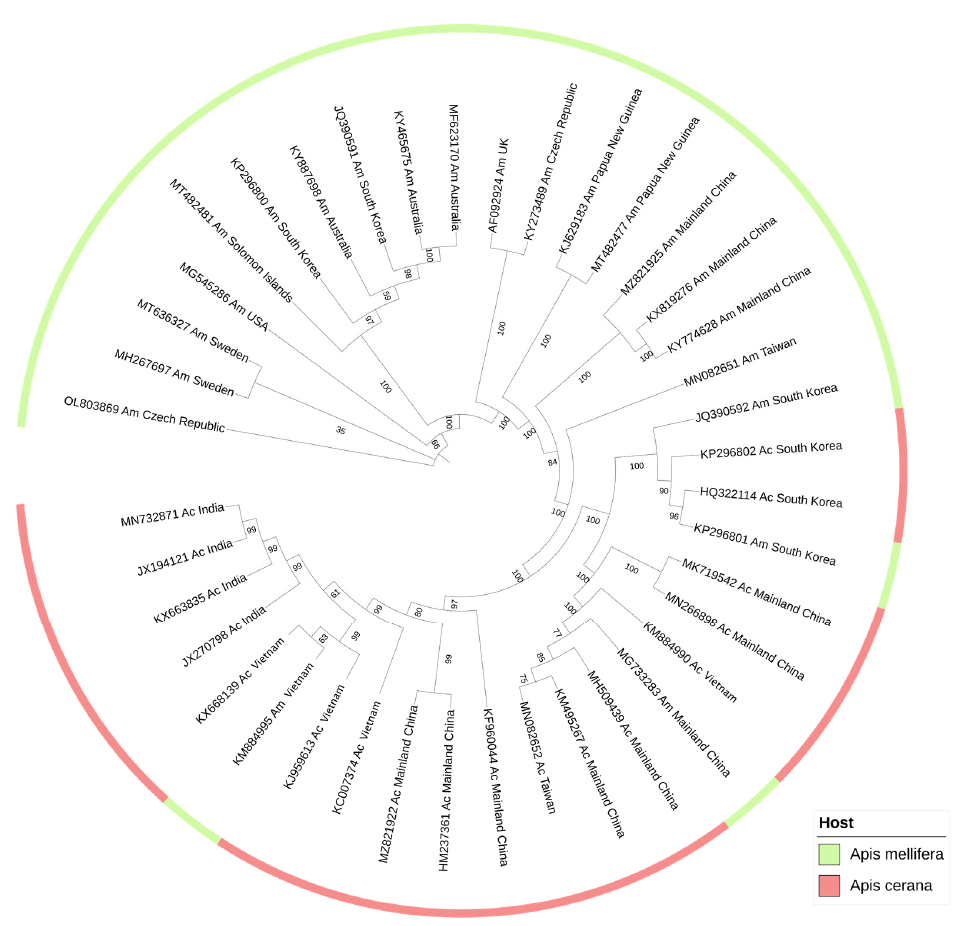
Figure 3. Phylogenetic tree of SBV. This tree was constructed based on the polyprotein sequences of 22 AmSBV and 18 AcSBV strains from the NCBI database. The phylogenetic tree was constructed using the maximum likelihood (ML) method and 1000 bootstrap replications. Strains are annotated to the GenBank accession number, virus host, and region of isolation. Am, Apis mellifera ; Ac, A. cerana . The tree consisted of two branches, mainly AcSBV and AmSBV strains. Nevertheless, the AcSBV cluster also contained four AmSBV isolates from China, South Korea, and